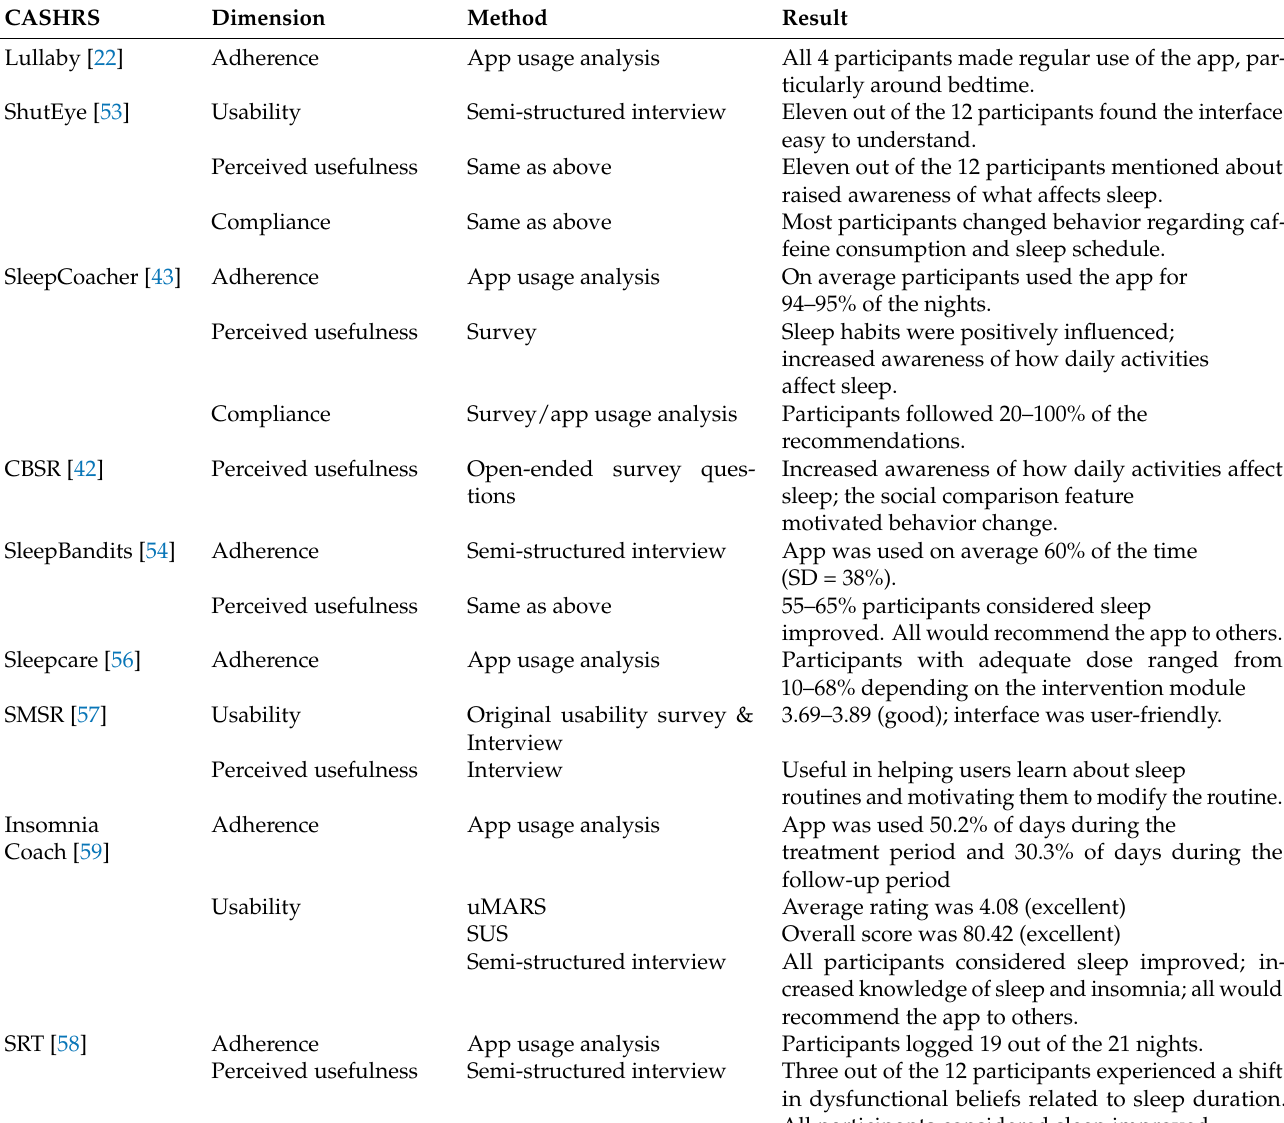
Table 10. CASHRS evaluation centered on human–computer